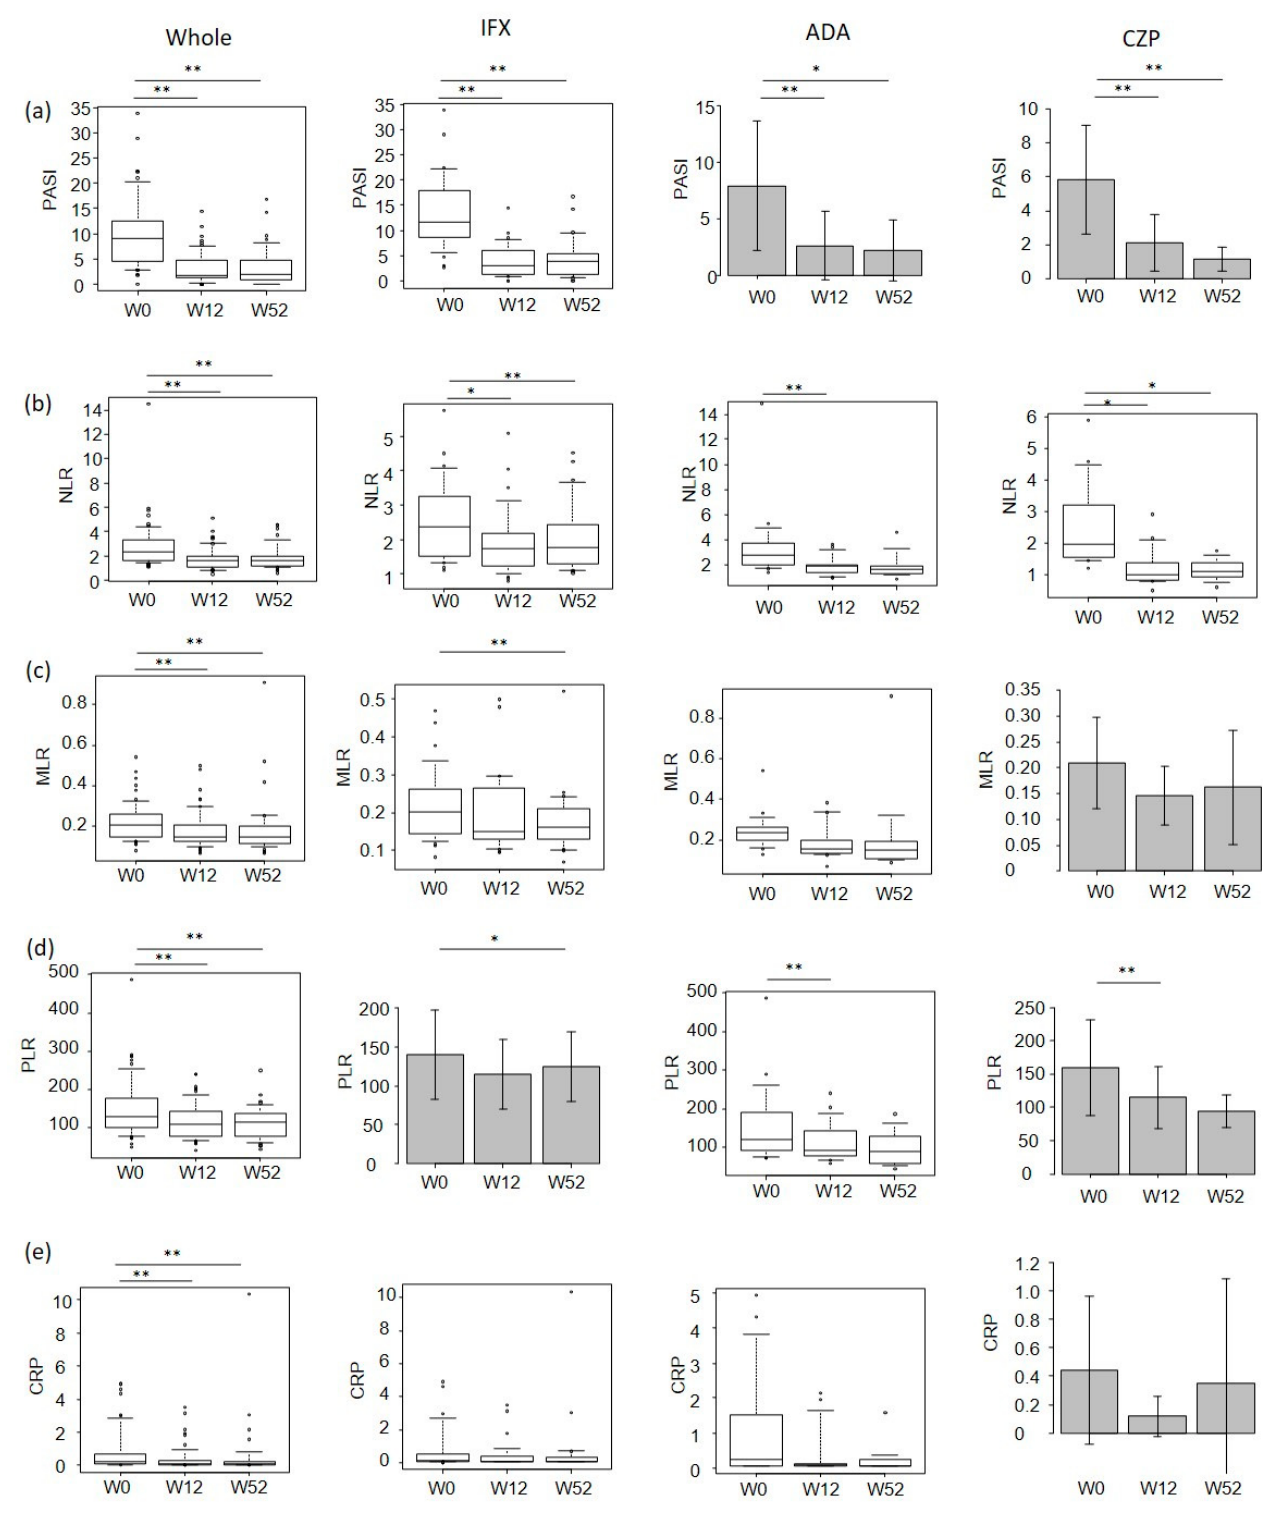
Figure 2. PASI ( a ), NLR ( b ), MLR ( c ), PLR ( d ) and CRP ( e ) values at 0, 12 or 52 weeks of individual TNF- α inhibitor treatments in patients with psoriasis. The ADA and CZP data in ( a ), CZP data in ( c ), IFX and CZP data in ( d ) and CZP data in ( e ) are provided as mean ± standard deviation and analyzed by repeated measure analysis of variance. Otherwise, data are provided as the median (interquartile range) and analyzed by Friedman’s test. * p < 0.05; ** p < 0.01.